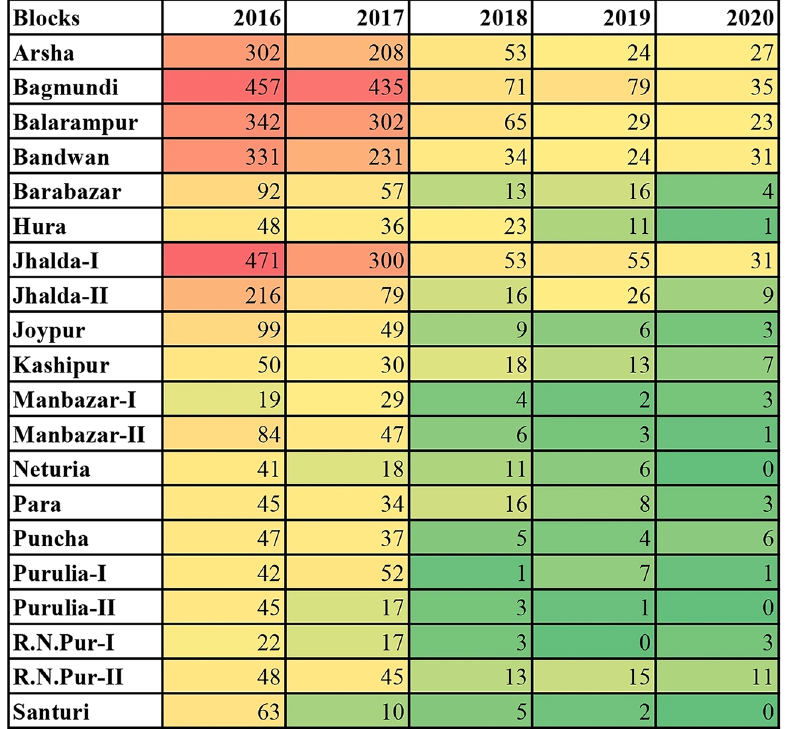
Figure 2. Heat map analysis of block-wise malaria cases in Purulia districtover the years 2016–2020. Color spectrum from red to green indicates progressive decrease in number of malaria cases. Green denotes the low number of cases; Red denotes high number of cases.